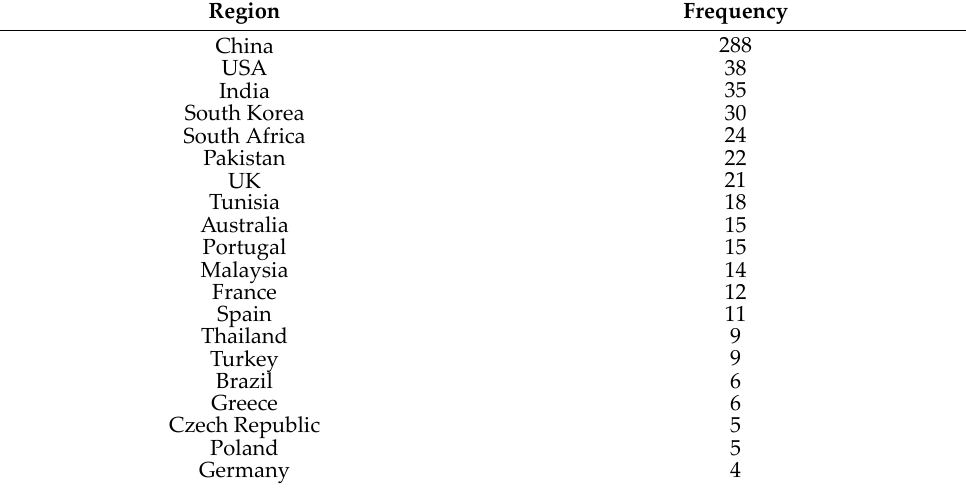
Table A3. Country/territory production.